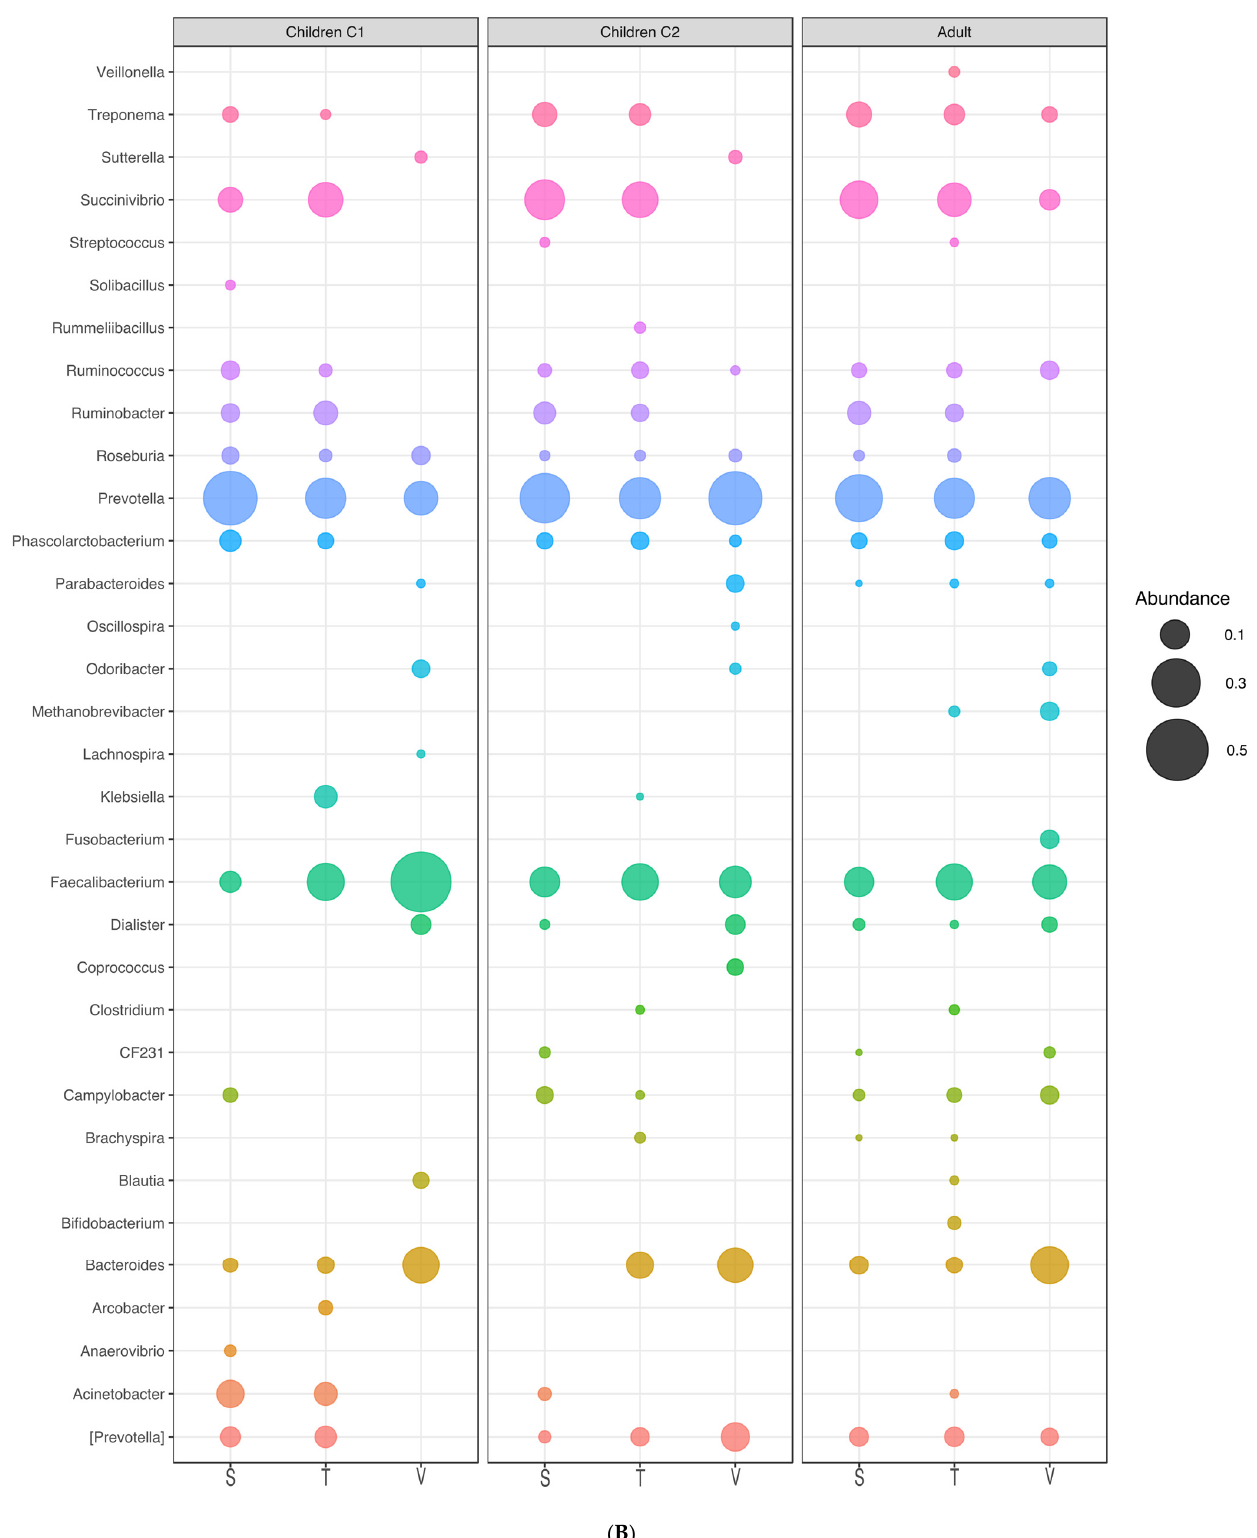
Figure 5. ( A ) Community composition by age group. Phylum distribution, unfiltered. Siminke (S), Tezhumake (T) and Valledupar (V). ( B ) Community composition by age group. B: Genera distribution (Genera > 2%). Siminke (S), Tezhumake (T) and Valledupar (V).